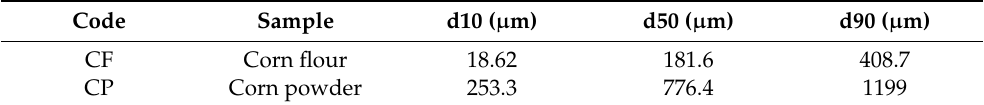
Table 1. Particle distribution of the corn materials.